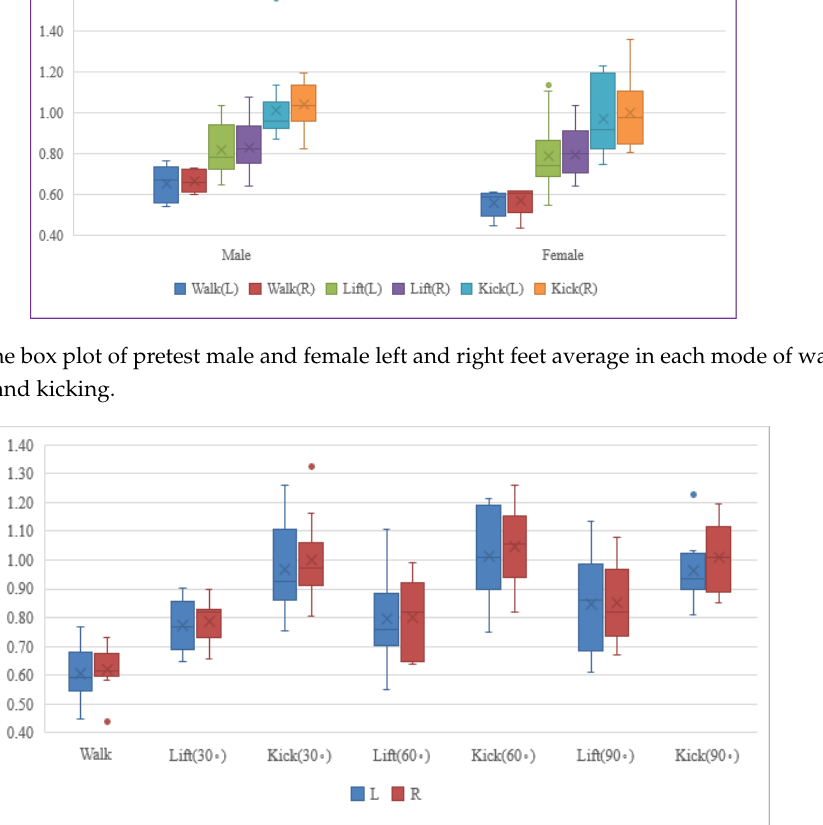
Figure 3. The box plot of pretest left and right feet average in each mode of walking, lifting legs and kicking (30°/60°/90°).